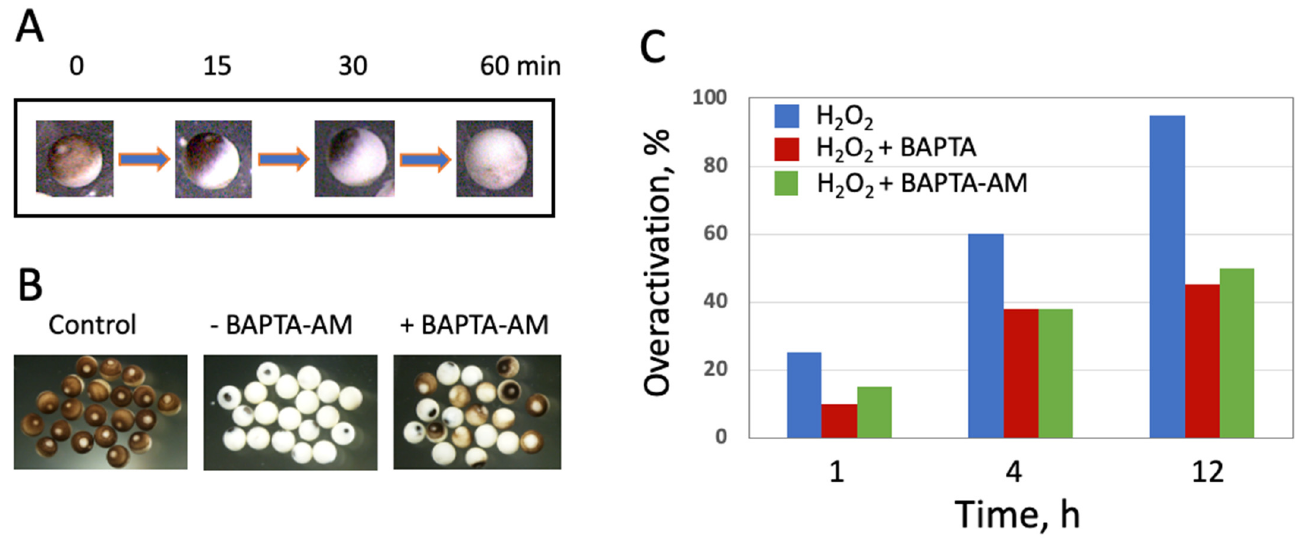
Figure 1. Involvement of calcium in the oxidative stress ‐ induced overactivation of frog eggs. The progression of morphological changes in the overactivated eggs is presented in panel A. At time “0”, a population of Xenopus eggs was treated with 10 mM hydrogen peroxide, and a responsive (i.e., overactivated) egg was monitored over one hour following drug administration (panel ( A )). Phenotypes of overactivated eggs treated with hydrogen peroxide for 12 h in the presence or absence of the selective calcium chelator BAPTA ‐ AM (100 μ M) are shown in panel ( B ). The rates of overactivation in the presence or absence of BAPTA or BAPTA ‐ AM at different times are shown in panel ( C ). The experiment was repeated with three separate batches of eggs obtained from different animals and the result of a single ‐ batch experiment is presented.